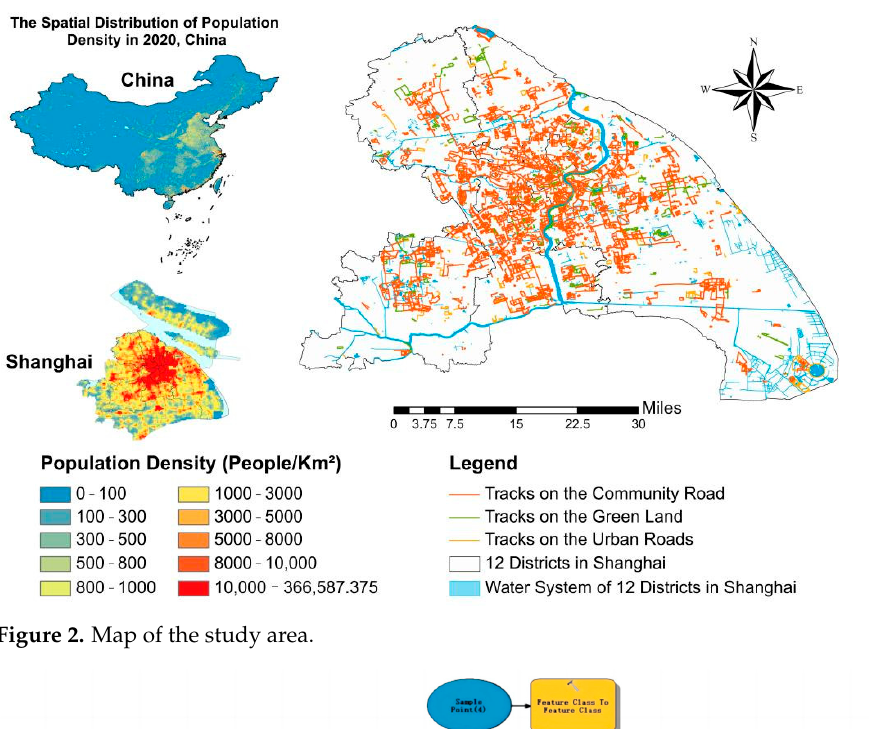
Figure 2. Map of the study area.